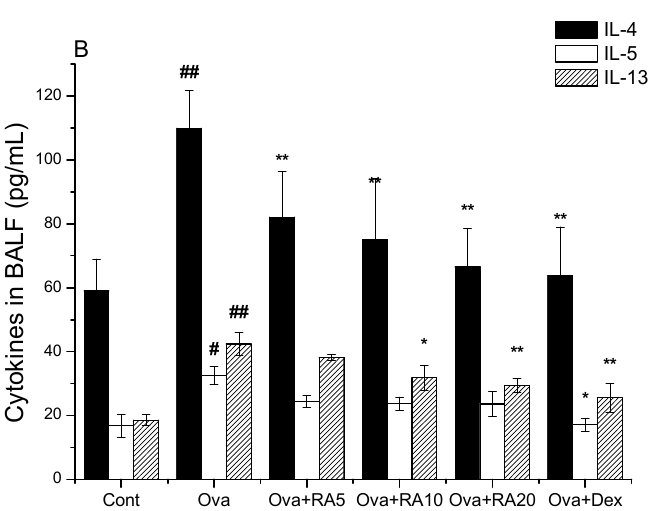
Figure 1. Effects of RA on inflammatory cells and secretion of Th2 cytokines in the BALF. BALF samples were obtained from the sensitized mice at 24 h after the last Ova challenge. The differential cell counts ( A ) revealed the numbers of total cells, neutrophil, eosinophil, and lymphocyte. The Th2 cytokines ( B ) were analysed via ELISA. The values represent the mean ± SEM of three independent experiments. # p < 0.05, ## p < 0.01 vs. control group; and * p < 0.05, ** p < 0.01 vs. Ova.